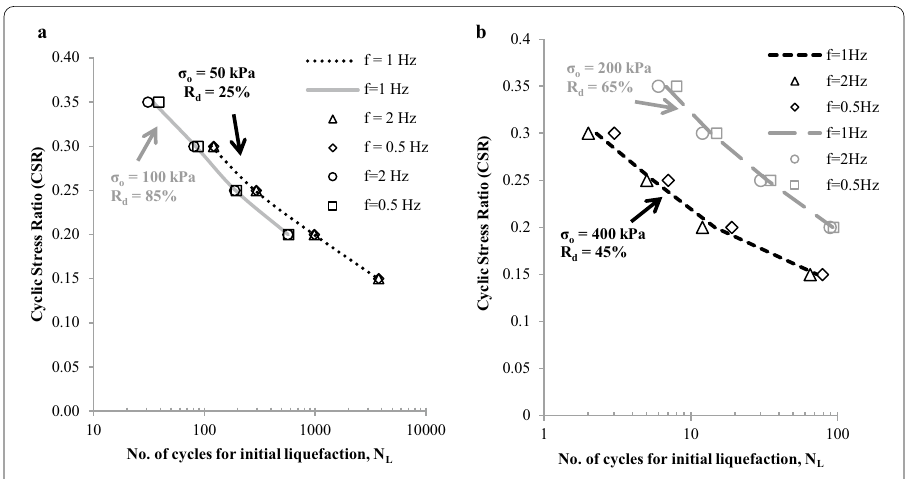
Fig. 11 Effect of frequency on CSR values of sand for a R d